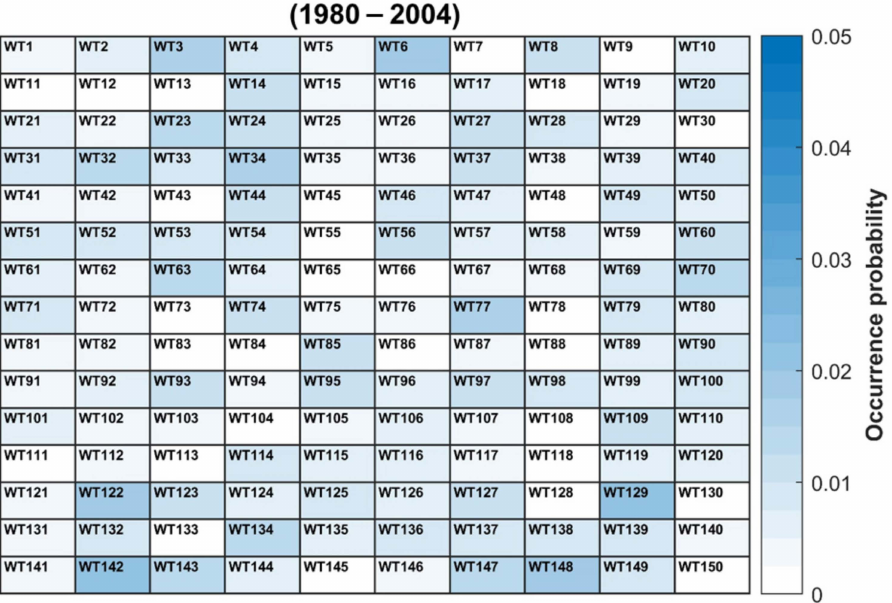
Figure 8. Occurrence probability of 150 weather types for the reference period from 1980 to